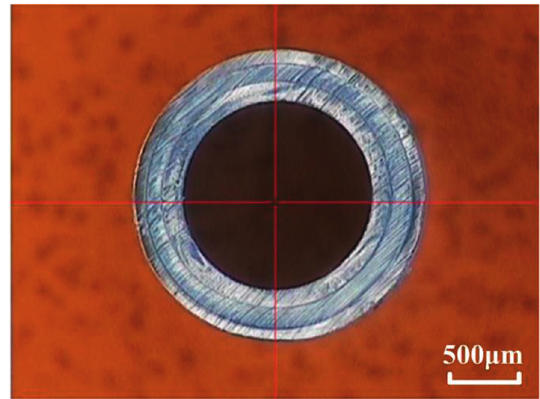
Figure 15: Cross section of three-layered balloon catheter with the optimal operating